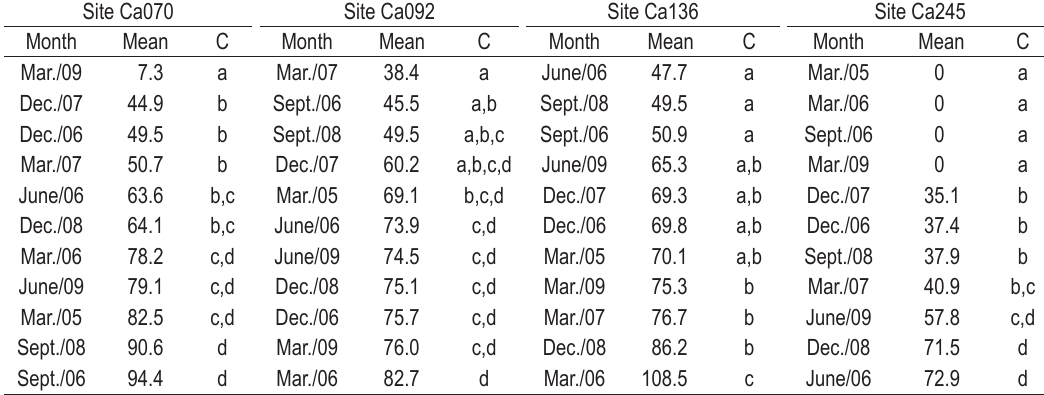
Table 1. Variation of mean number of births at each site and indication of similar groups. Means followed by the same letter did not differ significantly by LSD test (p ≤